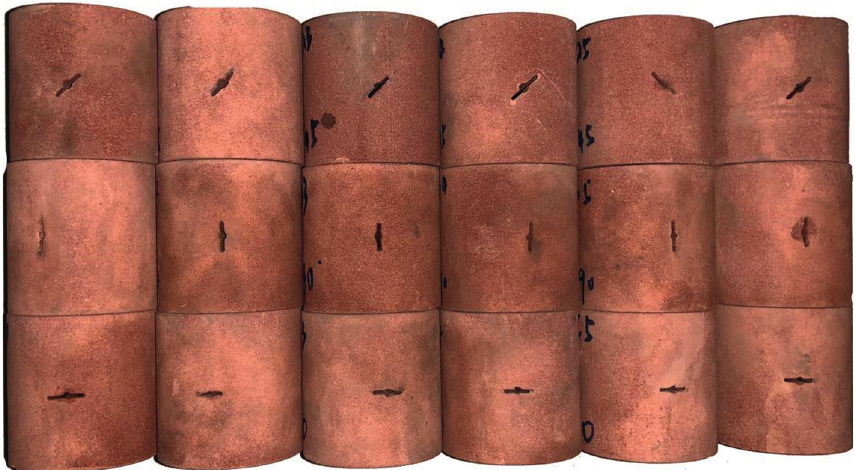
Figure 1: Specimens with prefabricated fractures at different dig